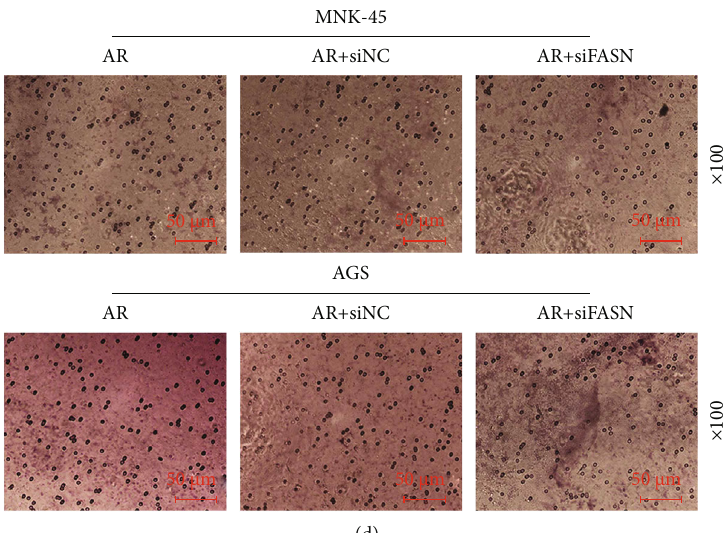
Figure 4: Small interfering RNA targeting fatty acid synthase (siFASN) suppressed cell migration and invasion. (a) Relative migration rates of MNK-45 and AGS cells in the anoikis resistance (AR), AR + small interfering RNA negative control (siNC), and AR + siFASN groups were determined by wound healing assay. (b) Relative invasion rates of MNK-45 and AGS cells in the AR, AR +siNC, and AR +siFASN groups were determined by transwell invasion assay. (c) Representative images of the migration of MNK-45 and AGS cell migration in the AR, AR +siNC, and AR +siFASN groups determined by wound healing assay. (d) Representative images of the invasion of MNK-45 and AGS cell invasion in the AR, AR +siNC, and AR+ siFASN groups determined by transwell invasion assay. ^^^ p < 0.001 vs. AR +siNC group. Data were performed as the means ±